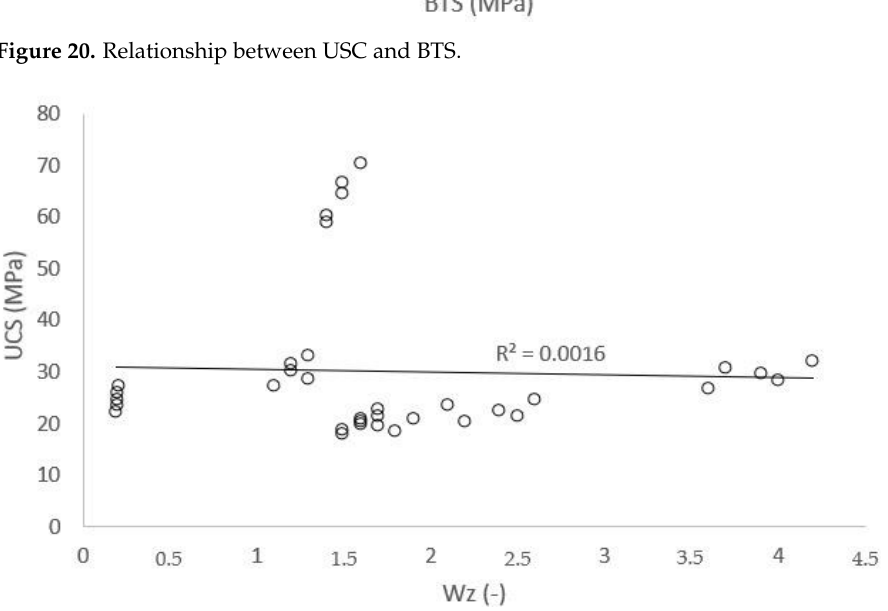
Figure 22. Relationship between quartz content and abrasivity index W z of tested sandstones.